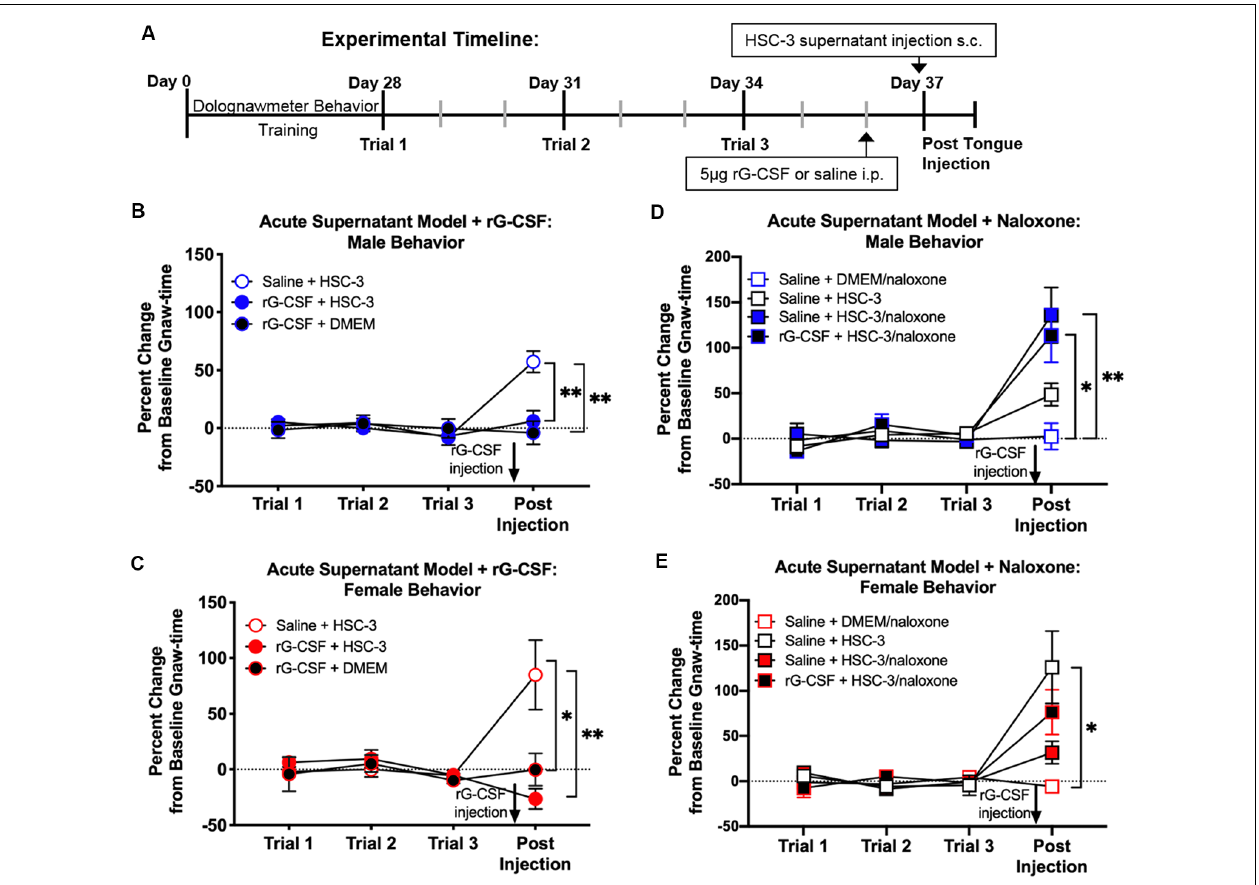
FIGURE 3 | Supernatant-induced nociceptive behavior was measured using the acute supernatant model. (A) Schematic of the experimental timeline for an acute supernatant model. Male and female C57Bl/6 mice were trained for 4 weeks in the orofacial pain behavior device and assay (dolognawmeter) or until a steady baseline gnaw-time was reached. Three additional baseline trials were completed and mice underwent a single intraperitoneal injection (i.p.) of saline or 5 µ g rG-CSF. Twenty-four hours after treatment, mice received either subcutaneous (s.c.) DMEM (rG-CSF+DMEM) or HSC-3 culture supernatant (saline+HSC-3, rG-CSF+HSC-3, N = 8/sex) into the tongue (50 µ l) followed by assessment in the dolognawmeter (Post-Injection). A separate group of mice received either s.c. DMEM or HSC-3 cell culture supernatant co-injected with opioid receptor antagonist naloxone (saline+DMEM/naloxone, saline+HSC-3/naloxone, rG-CSF+HSC-3/naloxone, N = 5/sex) into the tongue (50 µ l) followed by assessment in the dolognawmeter (Post-Injection). Orofacial nociceptive behavior data were analyzed as a percent change from the baseline gnaw-time prior to treatment. Supernatant-induced change in orofacial nociceptive behavior was measured in male (B,D) and female (C,E) mice and analyzed individually. Two-way ANOVA, ∗ P < 0.05, ∗∗ P < 0.01 by Holm-Sidak post hoc comparisons.